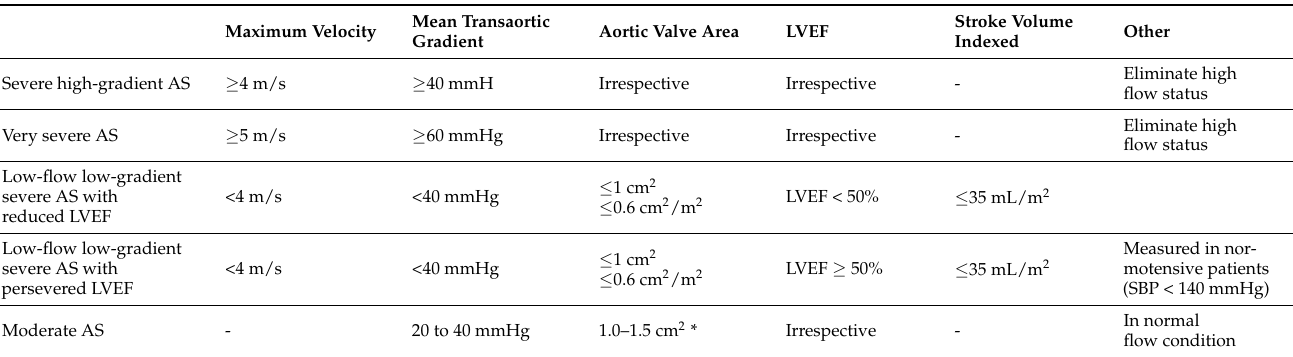
Table 2. Echocardiographic cut-off of aortic